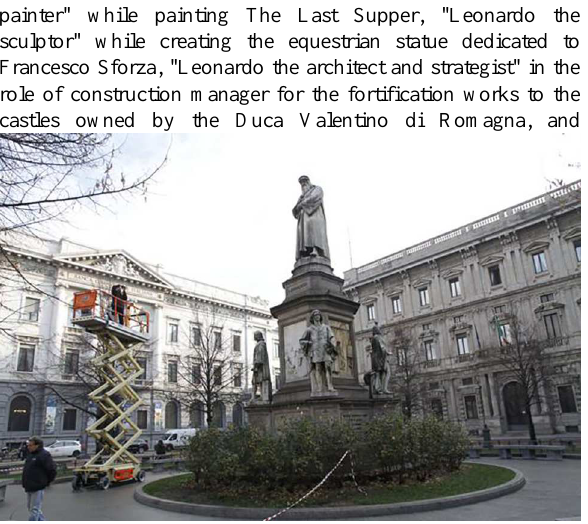
Figure 2. Steps of survey of the monument. 3D scan with